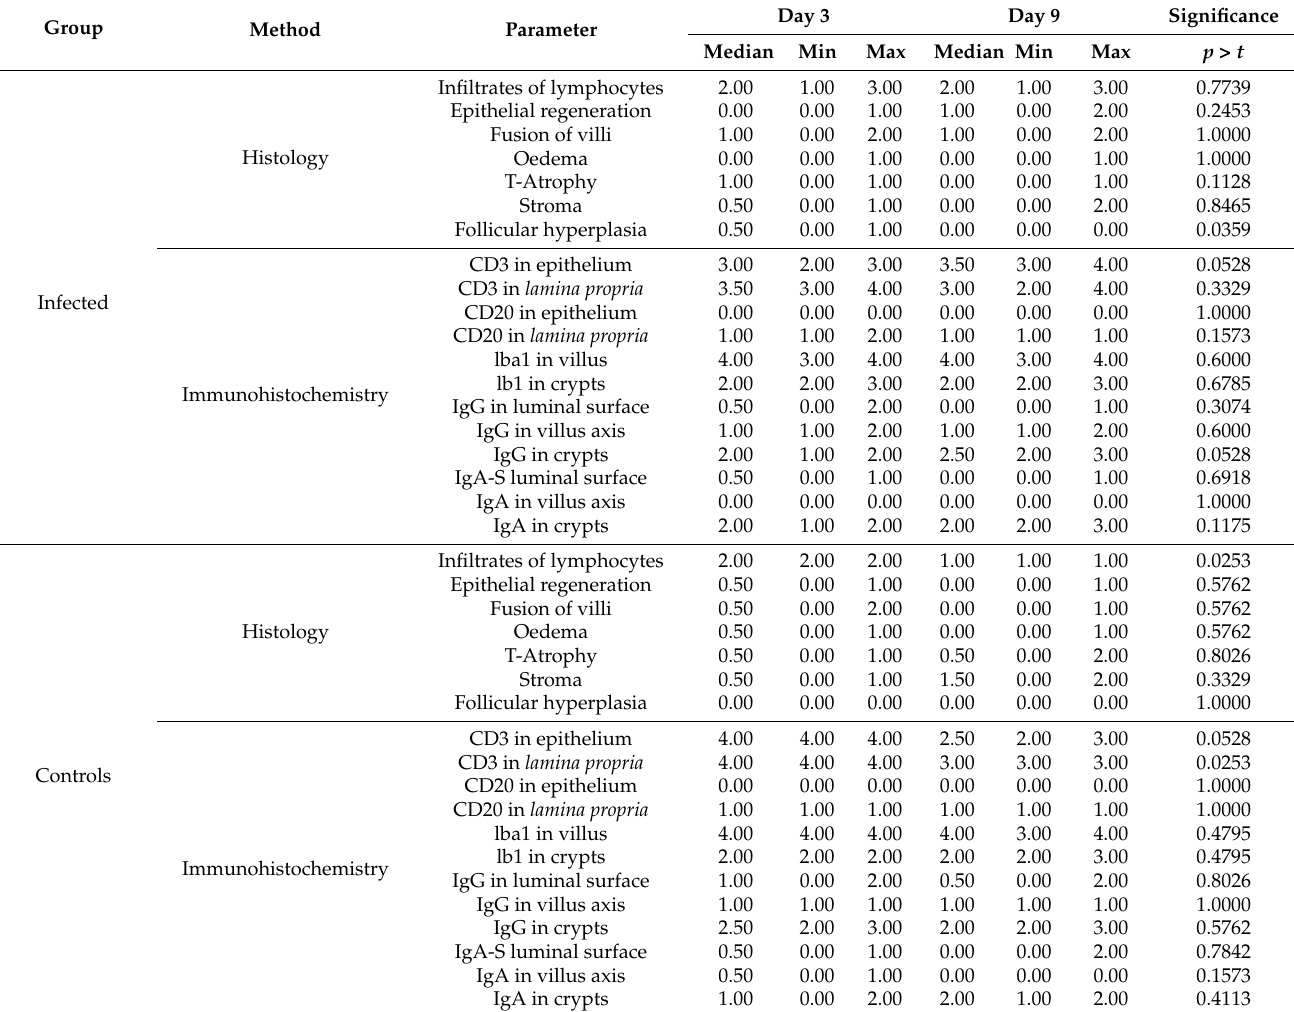
Table 5. Median histology and immunohistochemistry parameters obtained at 3 and 9 days for infected and controls.